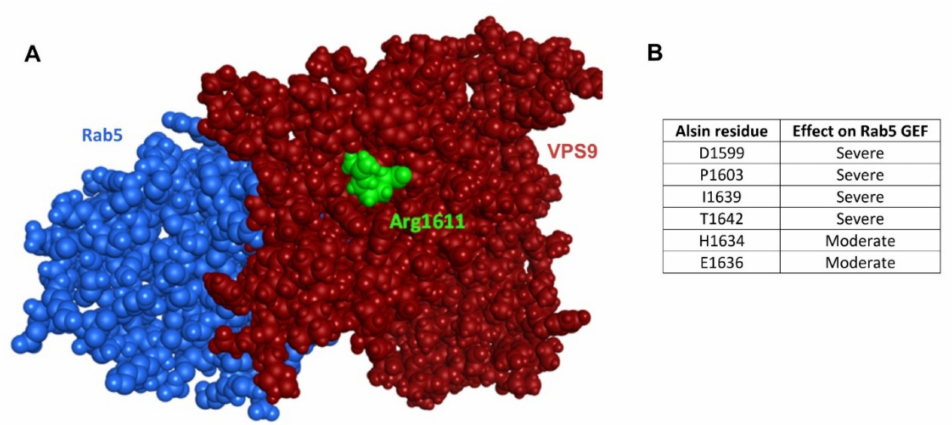
Figure 6. The interaction between Rab5 and VPS9 is not affected by residue 1611 mutation. ( A ) Inter- action model of Rab5 (blue) and VPS9 (red); residue 1611 is highlighted in green and shown to be far from the protein interaction interface. ( B ) Table of alsin’s residues homolog to the ones individuated in human Rabex 5 as essential for performing GEF activity. They are, in large part, conserved in human alsin, and position 1611 is not among